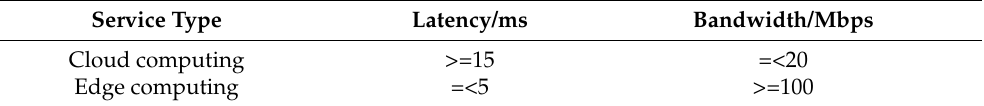
Table 2. Comparison of the latency and bandwidth.